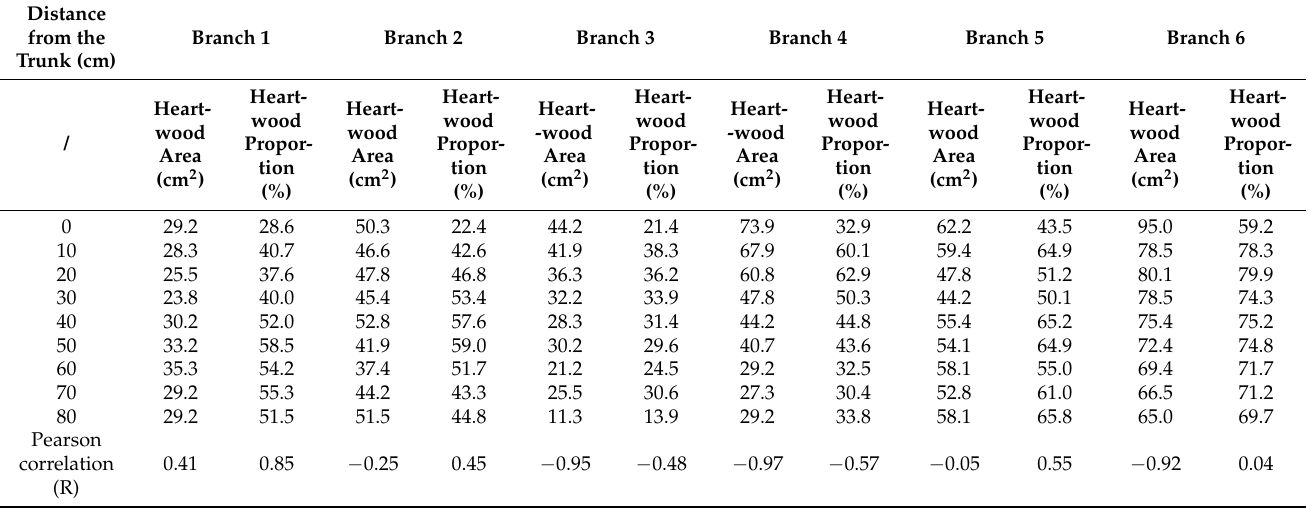
Table 3. Sapwood and heartwood areas and proportions of silver fir